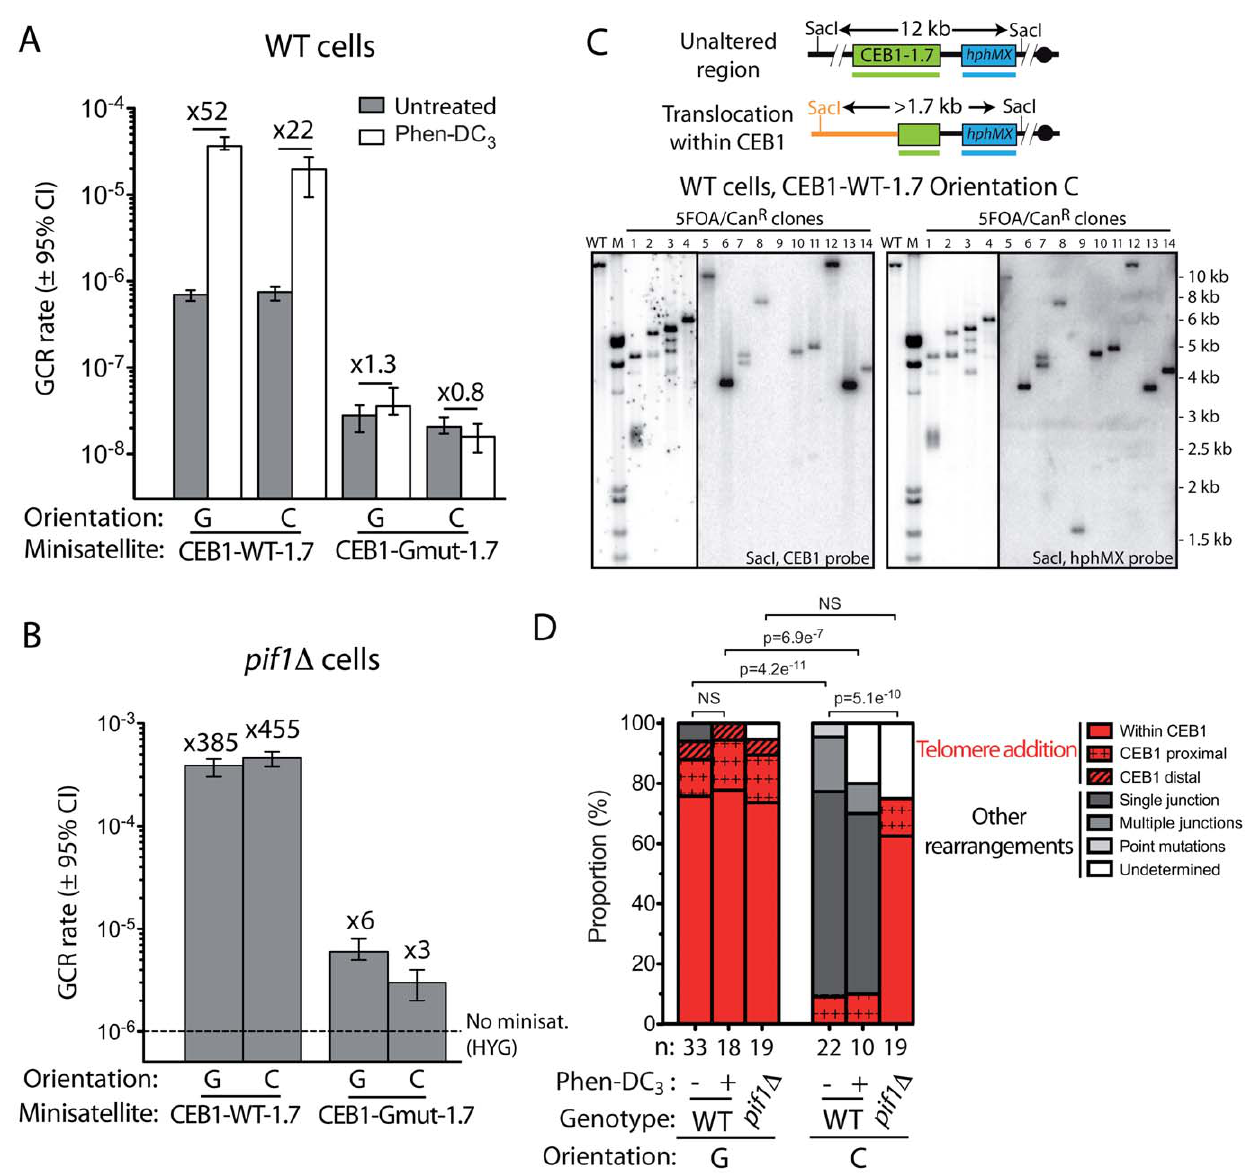
Figure 4. The nature of the GCR, but not the GCR rate, depends on the orientation of CEB1 in WT cells. (A) GCR rates in untreated (grey) and Phen-DC 3 -treated (white) WT cells bearing CEB1-WT-1.7 in the orientation G (ORT6542-6) and C (ORT6591-1), and CEB1-Gmut-1.7 in the orientation G (ORT6550-2) and C (ORT6548). The fold increases of the GCR rate upon treatment with Phen-DC 3 is indicated. (B) GCR rates in pif1 D cells bearing CEB1-WT-1.7 in the orientation G (ORT6543-1) and C (ORT7153-9), and CEB1-Gmut-1.7 in the orientation G (ORT6551-1) and C (ORT6549). The dotted line indicates the GCR rate in the ‘‘no minisatellite’’ control pif1 D strain (ORT6568) (see Figure 1D). Other legends as in Figure 1D. (C) The top panel schematically represents the genomic region surrounding CEB1 with the Sac I restriction site and CEB1 (green) and hphMX (blue) probes used to study rearrangements of the region. The size of the unaltered region upon digestion is indicated. The example of a translocation within CEB1 is shown, and is expected to produce a fragment longer than 1.7 kb. The bottom panels show the rearrangements present in 14 5FOA/Can-resistant clones obtained from independent cultures of WT cells bearing CEB1-WT-1.7 in the orientation C, and in the parental 5FOA/Can-sensitive strain (WT, ORT6591-1). In most lanes the bands hybridized both the CEB1 and the hphMX probes, except in clone 9 in which CEB1 has been lost. M=Size marker. (D) Nature of the GCR determined by Southern blot analysis of independent 5FOA/Can-resistant colonies derived of cells bearing CEB1-WT- 1.7 in the orientations G or C, in WT cells treated or not with Phen-DC 3 10 m M, or in pif1 D cells. The results are presented as a percentage of the total number (n) of 5FOA/Can-resistant colonies analyzed. Telomere additions are shown in red, and their locations relative to CEB1 are indicated by different motifs: within CEB1 (no motif), in proximal (cross), or in distal (lines) position to CEB1. Other rearrangements that appear as discrete bands on the Southern blots are shown in grey: single junction (only one band) and multiple junctions (more than one band) are shown in dark grey and grey, respectively. The strain point mutated for URA3 and CAN1 (point mutations) is shown in light grey. In some instances, colonies have lost both CEB1 and hphMX and the junction has not been determined (Undetermined, white): this may correspond to telomere additions or other rearrangements in the 8.3 kb region between hphMX and the first essential gene ( PCM1 ). Distributions were compared using the Fisher’s exact test.